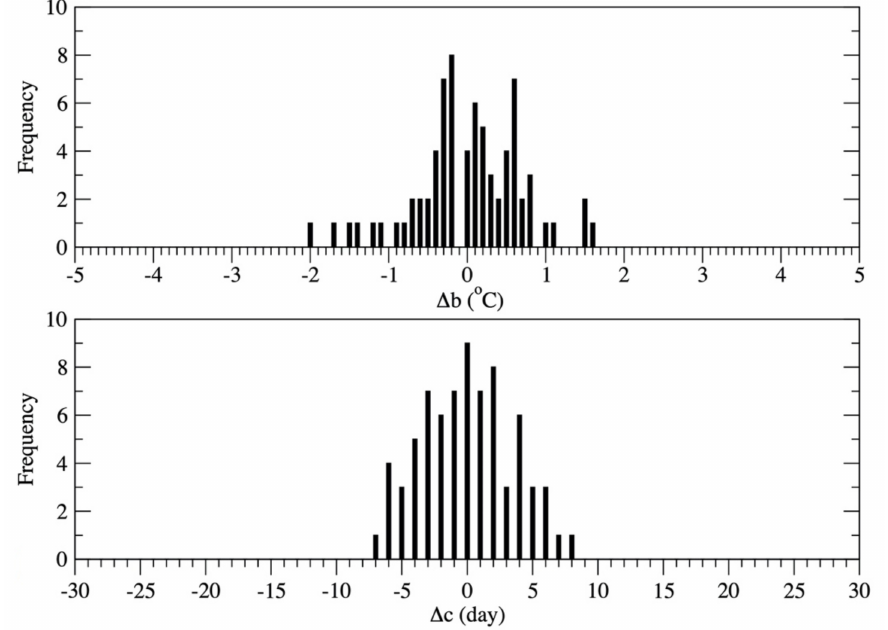
Figure 3. Probability distributions of ∆ b and ∆ c